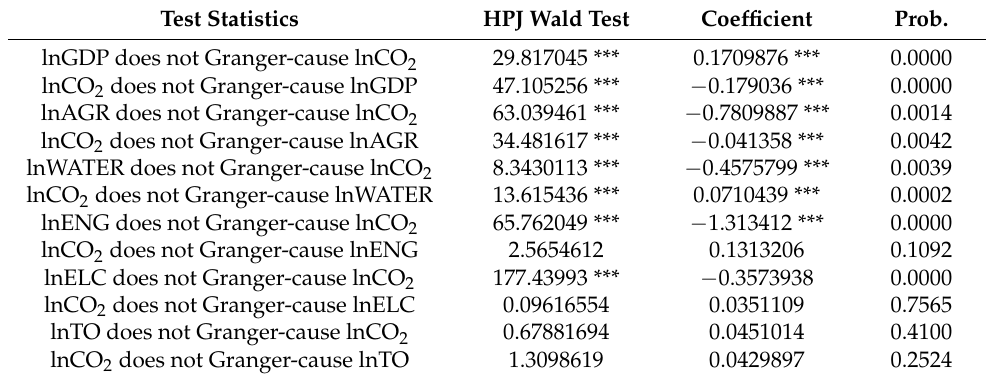
Table 8. Juodis, Karavias and Sarafidis (2021) Granger non-causality test results. Test